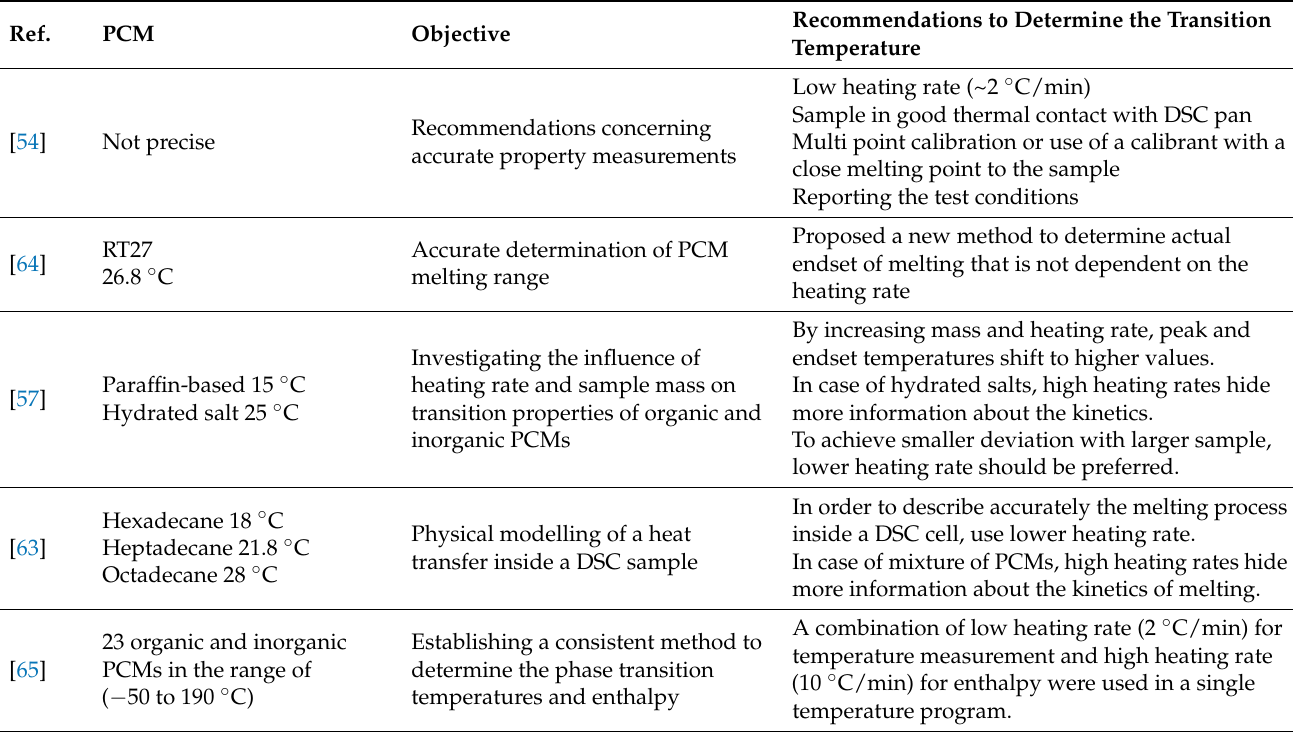
Table 6. Studies on the transition temperature of